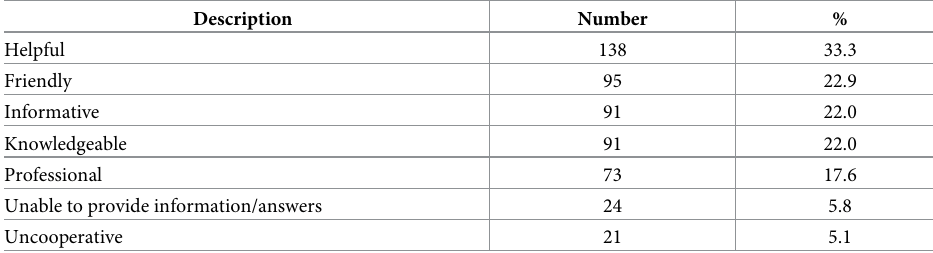
Table 5. Respondents’ evaluation of the vaccination